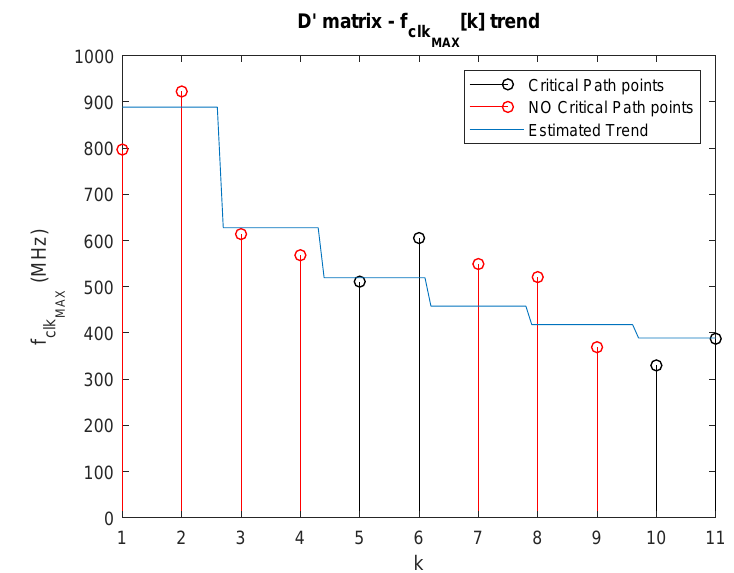
[ k ] trend relative to the D (cid:48) MAX